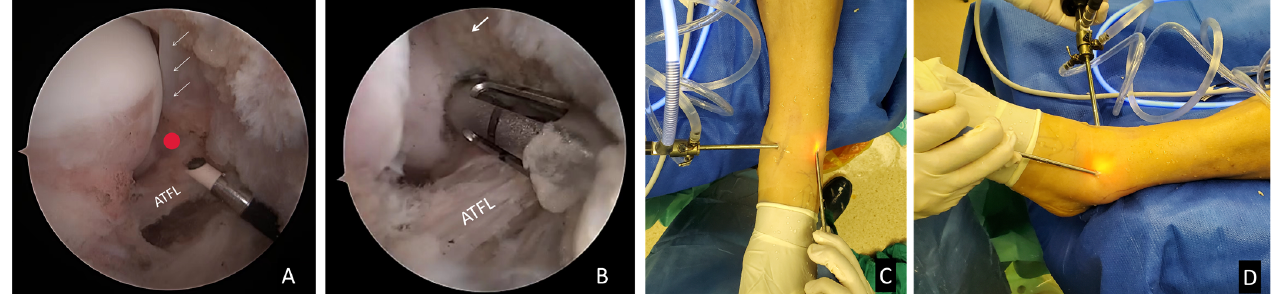
Figure 3. ( A ) The ATFL fibular footprint (red dot) is located approximately 5 mm inferior to the distal bundle of the anterior inferior tibiofibular syndesmosis (white arrow). ( B ) An anchor is placed in the footprint. ( C ) Top view, the direction of the anchor is parallel to the lateral surface of the talus. ( D ) Lateral view, with the anchor oriented at an approximately 45-degree angle to the lateral malleolus. little bit of the loop wire between the ATFL and the lateral joint capsule was withdrawn,